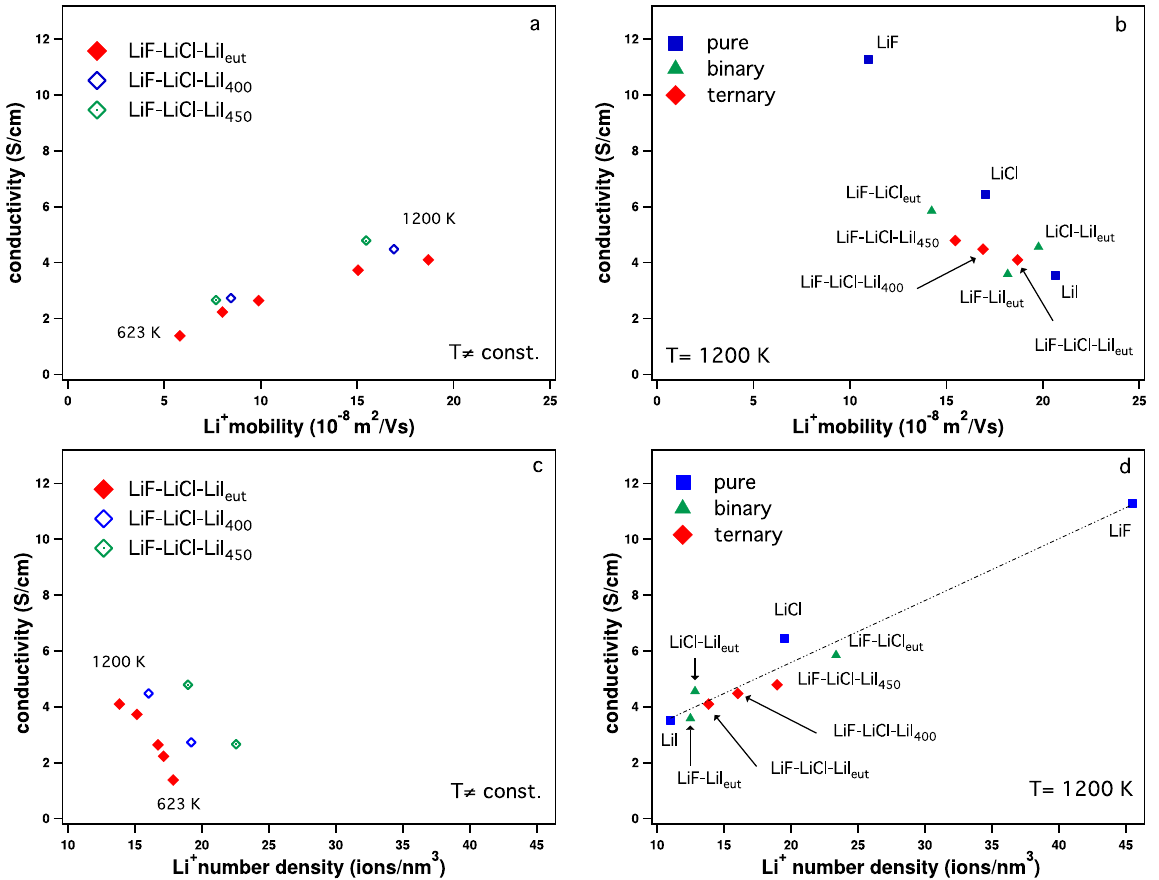
Fig. 1 Conductivity as a function of Li + mobility and number density. Conductivity vs. Li + mobility ( a , b ) and vs. Li + number density ( c , d ). a , c At different temperatures for LiF-LiCl-LiI eut (623, 723, 773, 1000, and 1200 K) and for LiF-LiCl-LiI 400/450 (773 and 1200 K), a higher mobility and lower number density correspond to a higher temperature. b , d At the same temperature for various all-Li + systems (LiF, LiCl, LiI, LiF-LiCl eut , LiF-LiI eut , LiCl-LiI eut , LiF-LiCl-LiI eut , LiF- LiCl-LiI 400 , and LiF-LiCl-LiI 450 ) at 1200 K, the mobility and number density are a function of the system composition. Numerical details are provided in Supplementary Note 1 and Supplementary Tables 1 and